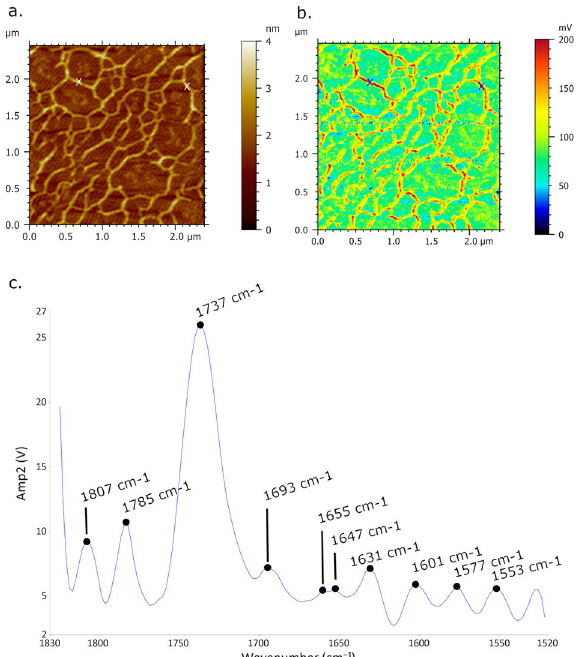
Figure 1. AFM-IR imaging of DNA network formed upon spermidine pretreated mica surface. Size of imaged area: 2.4 × 2.4 µm. ( a ) AFM topography image of DNA and corresponding. ( b ) AFM-IR absorption map of DNA network recorded at optimized wavenumber 1728 cm −1 showing DNA of higher absorbance (bright red porous contour) regarding to underlying mica surface. ( c ) AFM-IR spectra acquired and collected from two positions of DNA (blue cross in ( a ) and ( b )) showing prominent broaden band peaks of C=O stretching with absorption maxima at 1737 cm −1 .